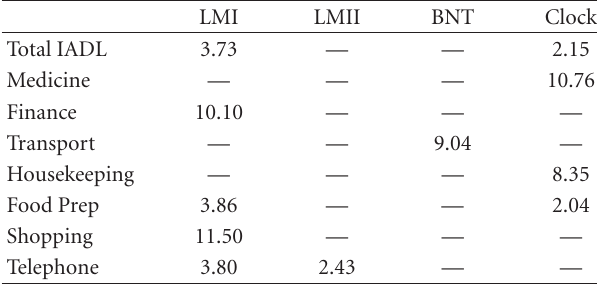
Table 4: t values of predictors of IADLs in